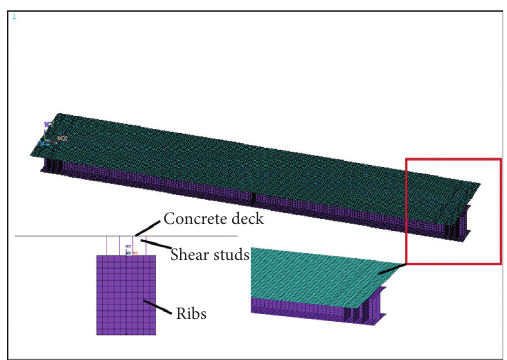
Figure 6: The constructed FE-based SCCPB model.